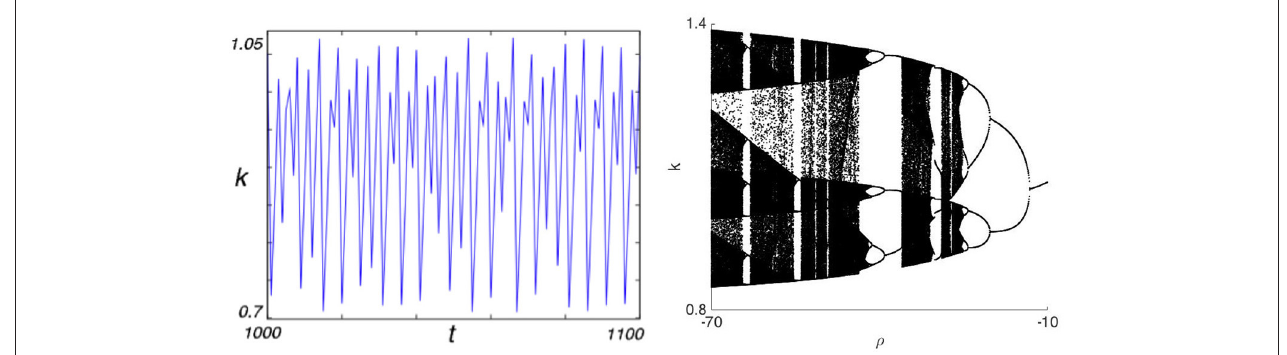
FIGURE 2 | (Left) Time-line of BK model with f c production function for ρ < 0 and s r > s w . (Right) Bifurcation diagram w.t.r. ρ (parameter related to the elasticity of